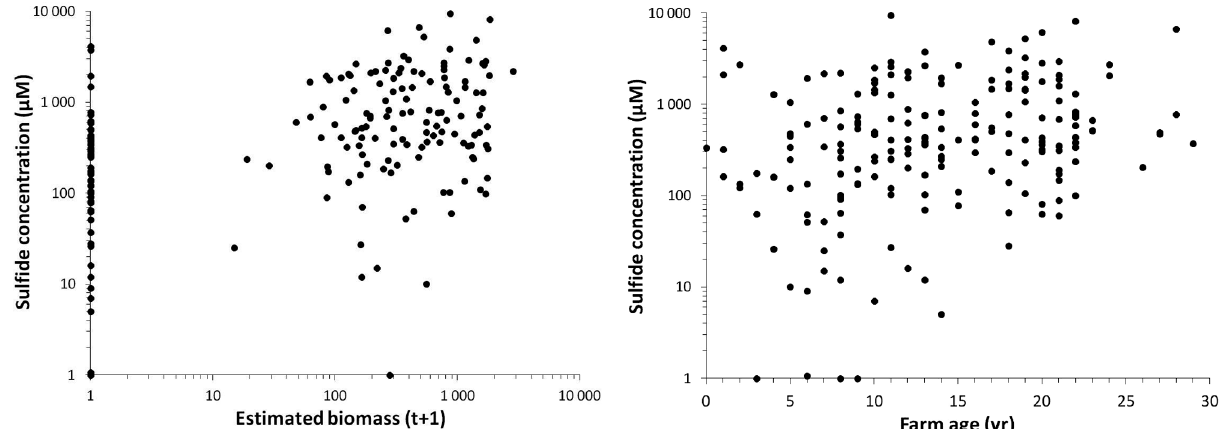
Fig. 4. Semi-log relationship between farm age and average sediment sulfide concentration in annual regulatory moni- toring at salmon farms in SWNB, 2006 to 2009